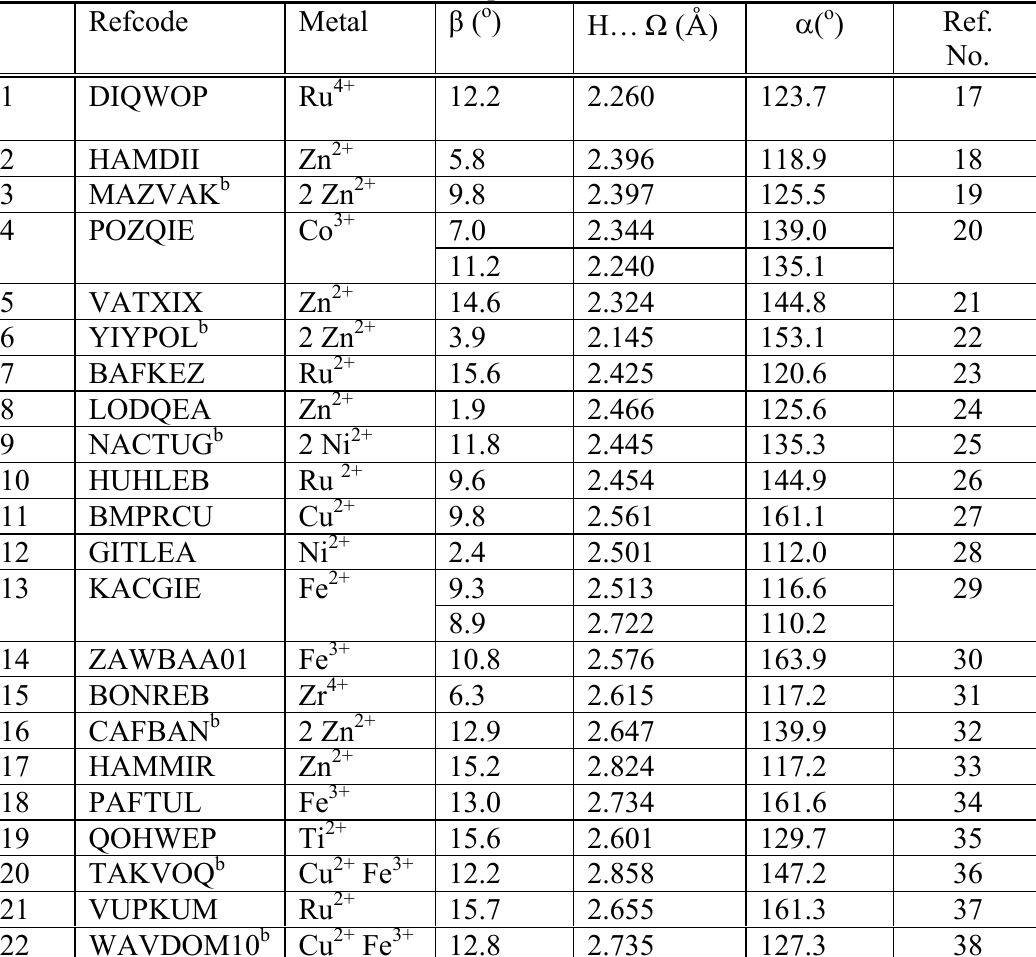
Table 1. Some of geometrical data a for intramolecular C − H ⋅⋅⋅π interaction in metal-porphyrin complexes